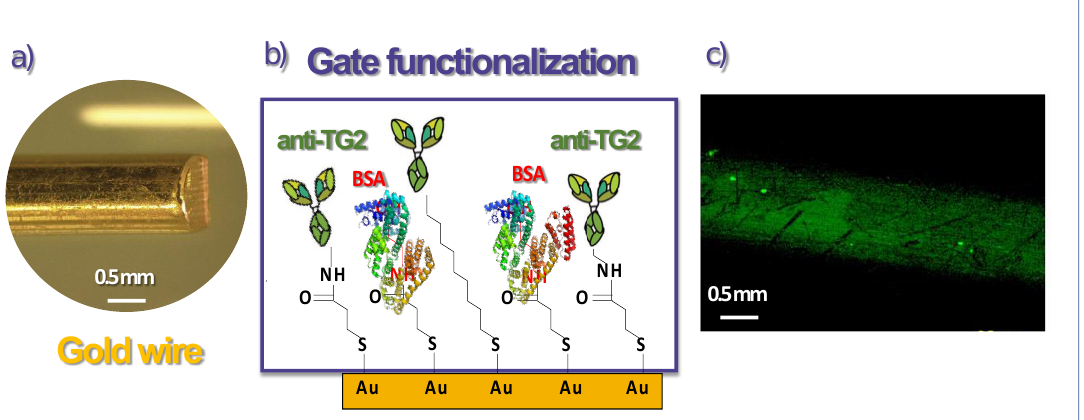
Figure 1. ( a ) Image of the gold wire used as gate electrode; ( b ) Cartoon of gate functionalization; ( c ) CLSM imaging of the gate electrode.